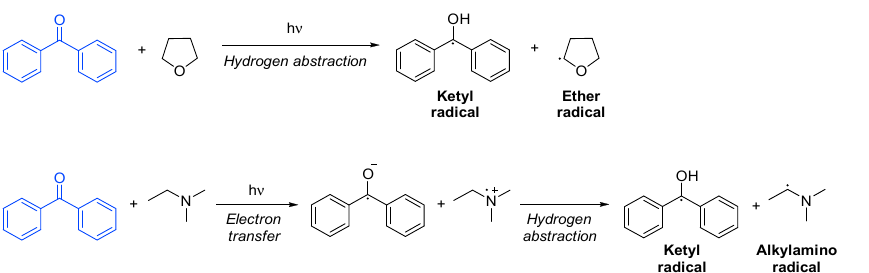
12 of 21 Figure 3. Jablonski diagram illustrating the photoinitiation of a type I acetophenone initiator. 3.3.2. Bimolecular Photoinitiators